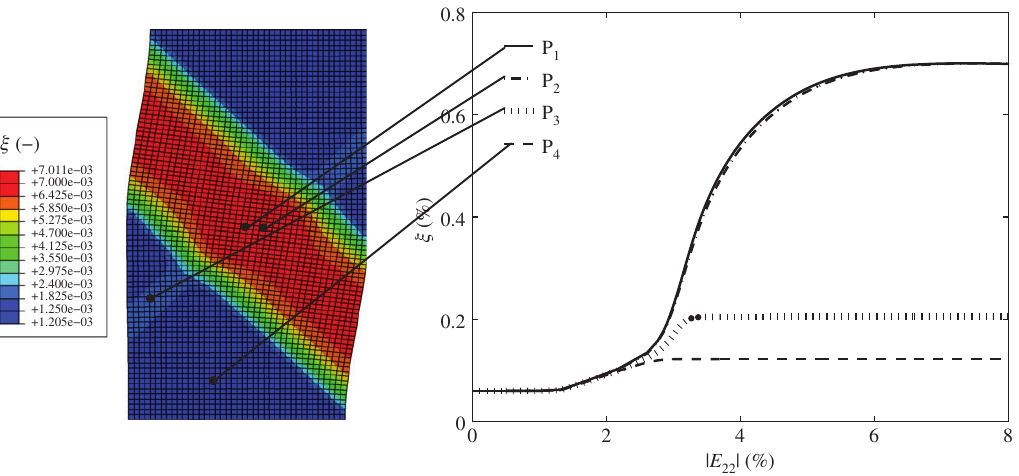
Figure 7 Sample S , general model behavior: free volume ξ over applied strain | E 1 mesh that shows the free-volume distribution ξ at | E P , element within shear band and with initial defect; P 1 outside localized regions.